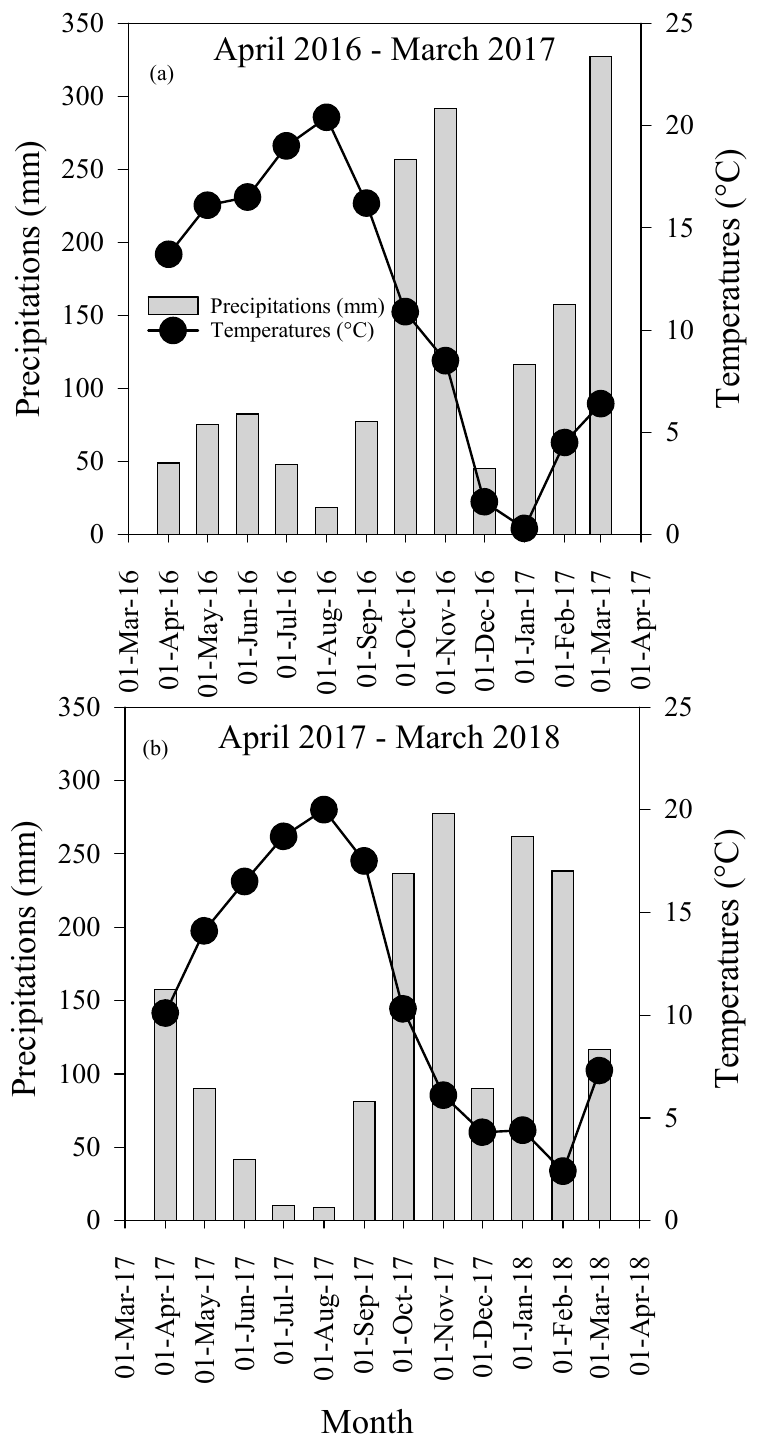
Figure 1. Average monthly precipitation and air temperatures during the periods ( a ) April 2016–March 2017 and ( b ) April 2017–March 2018.